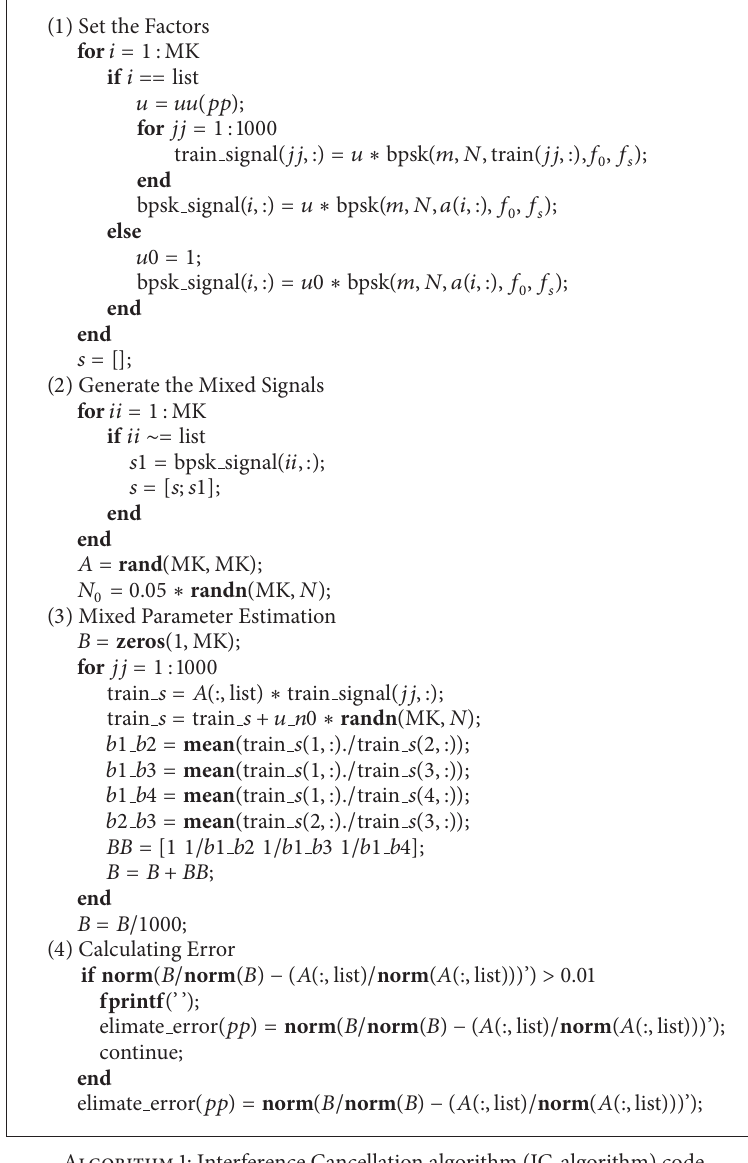
Algorithm 1: Interference Cancellation algorithm (IC-algorithm)